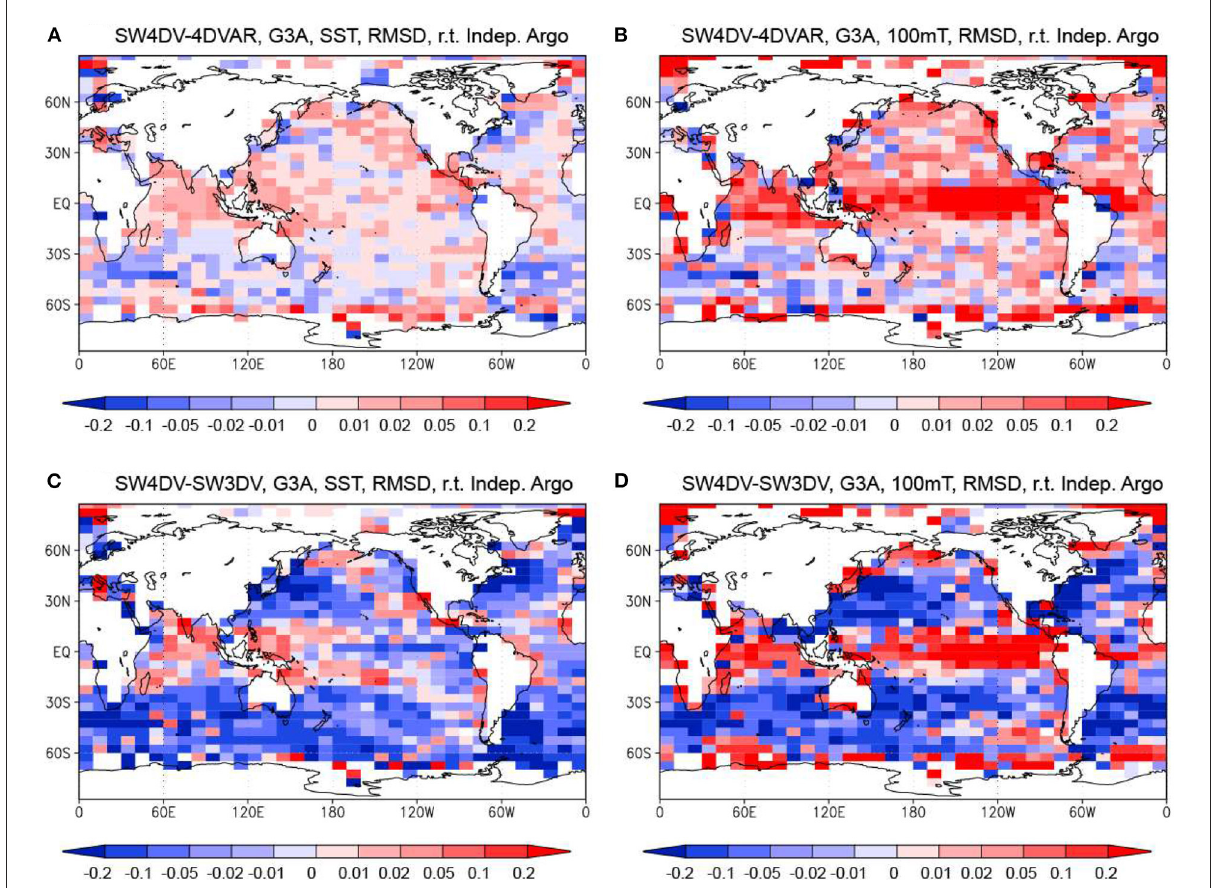
FIGURE12 Difference of RMSDs of the MOVE-G3A temperature relative to the independent Argo float data between the SW4DV and 4DVAR Runs (A, B) and between the SW4DV and SW3DV Runs (C, D) . (A, C) Difference of the RMSD at the surface. (B, D) Difference of the RMSDs at 100m depth. Blue colors mean that the RMSD are smaller for the SW4DV Run. Units in ◦